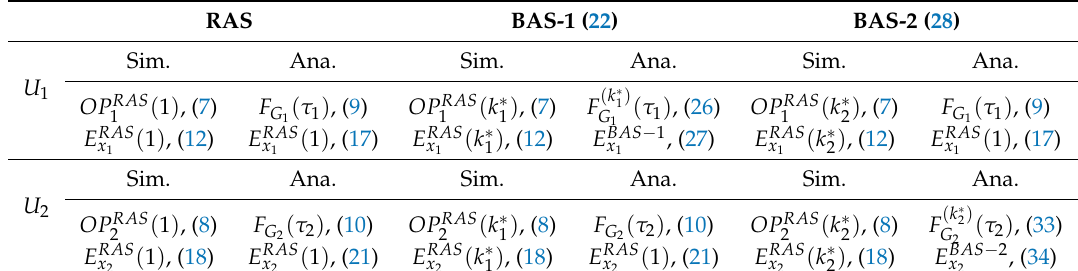
Table 1. A summary of the